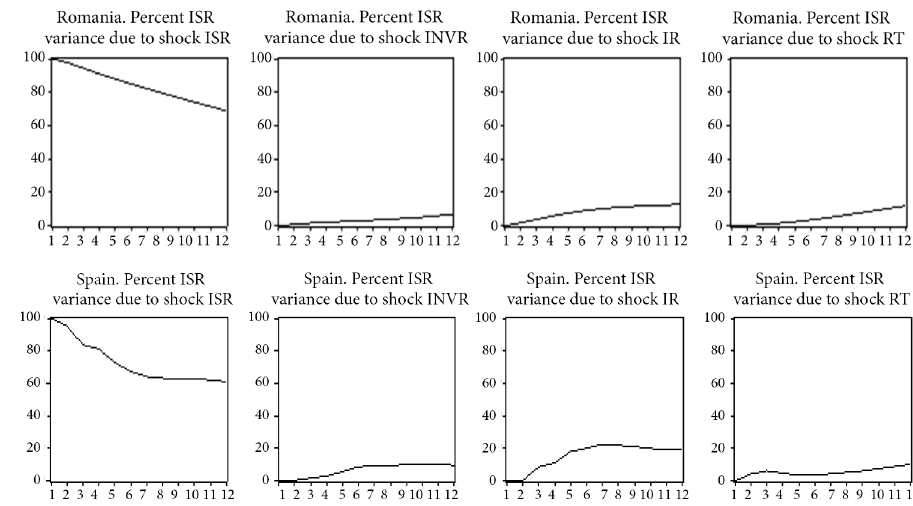
Figure 3. Variance